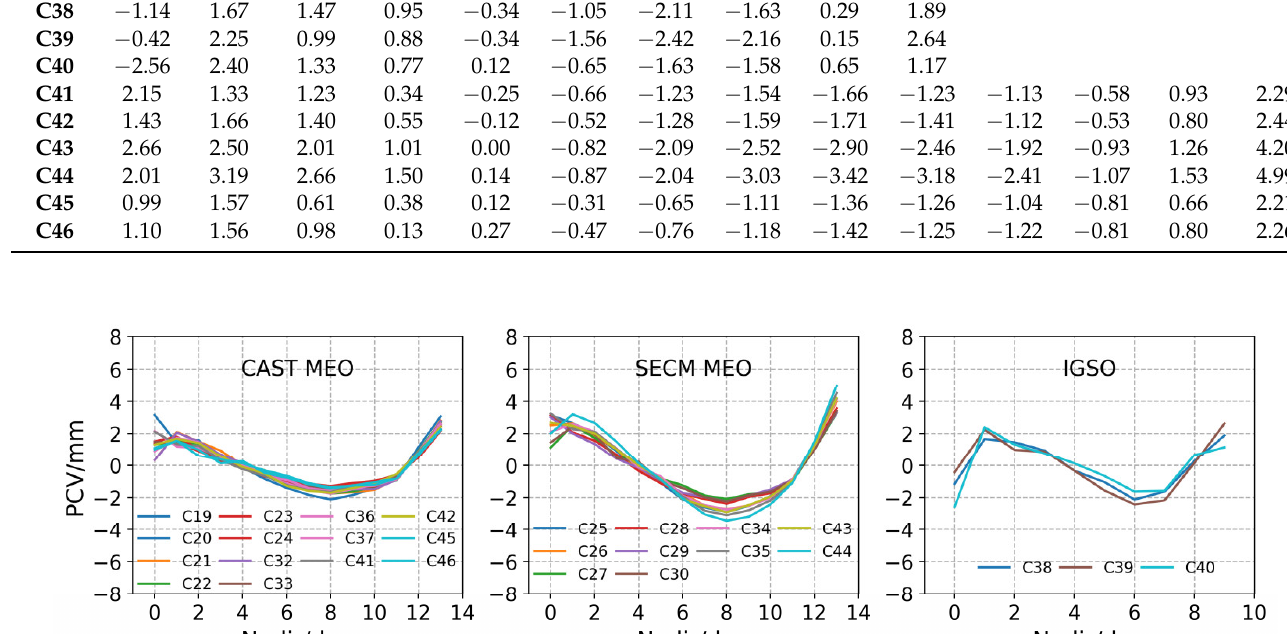
Figure 8. The Δ of 2-Step Scheme and 3-Step Scheme.